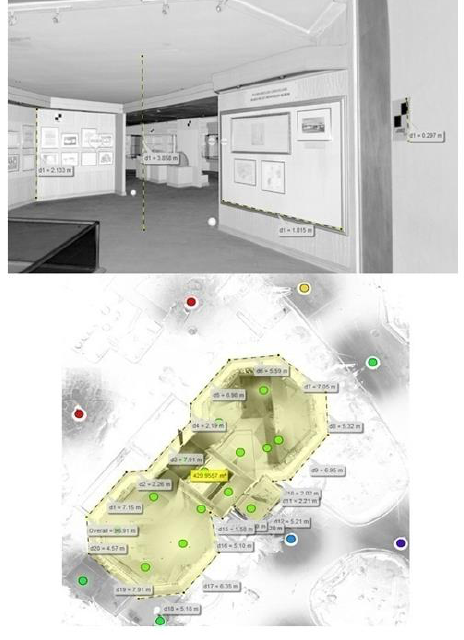
Figure 19: Measurement taken at the museum